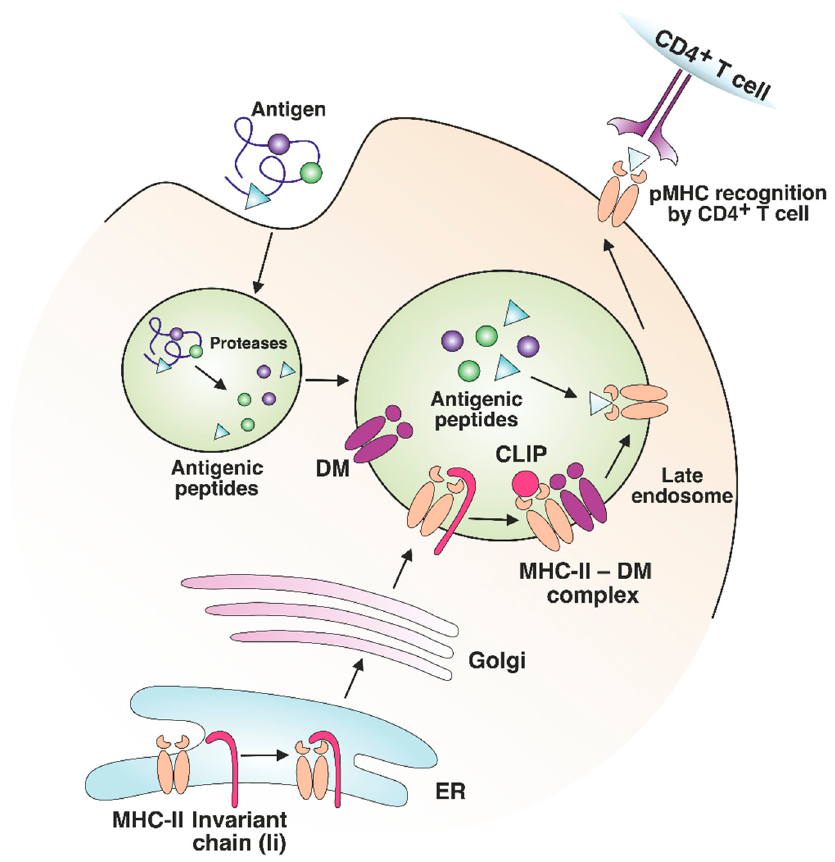
Figure 2. MHC-II maturation and antigenic peptide loading. MHC-II molecules are synthesized in the endoplasmic reticulum (ER) and loaded with an invariant chain (Ii). The MHC-II complex with Ii is transported through the Golgi to the late endosome. Endosomal proteases process antigens to short peptides and Ii to shorter class II-associated invariant chain peptide (CLIP). The binding of a nonclassical HLA-DM (DM) molecule to MHC-II promotes CLIP exchange to the antigenic peptide with an optimal binding register. The formed pMHC complex is transported to the surface of the APC for CD4 + T cell recognition.